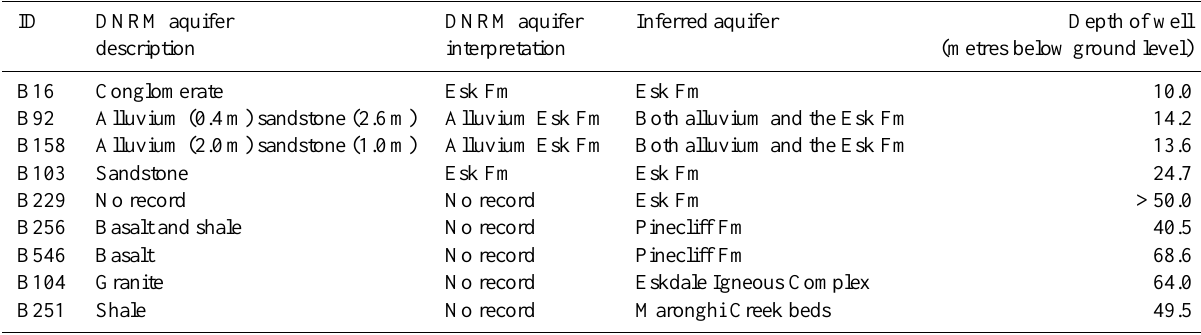
Table 1. Geological description of bedrock hydrochemical sampling sites (DNRM,